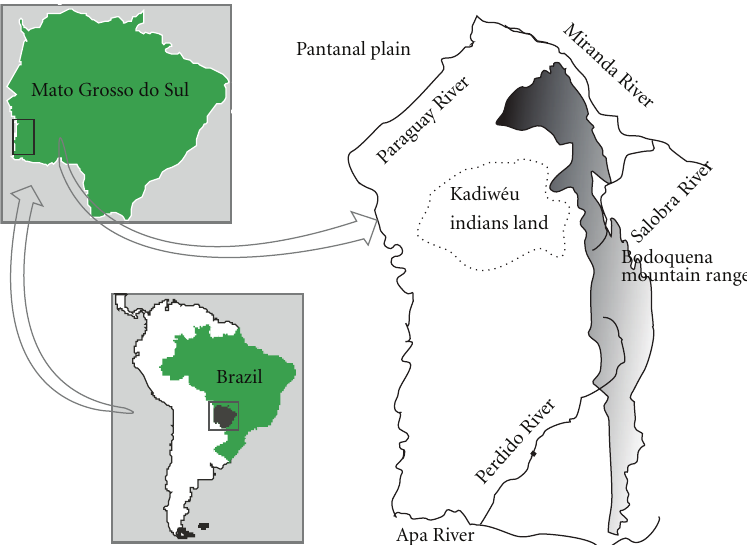
Figure 1: Map of Serra da Bodoquena (Chacoan sub-region), bordering the Pantanal province, State of Mato Grosso do Sul, Brazil.